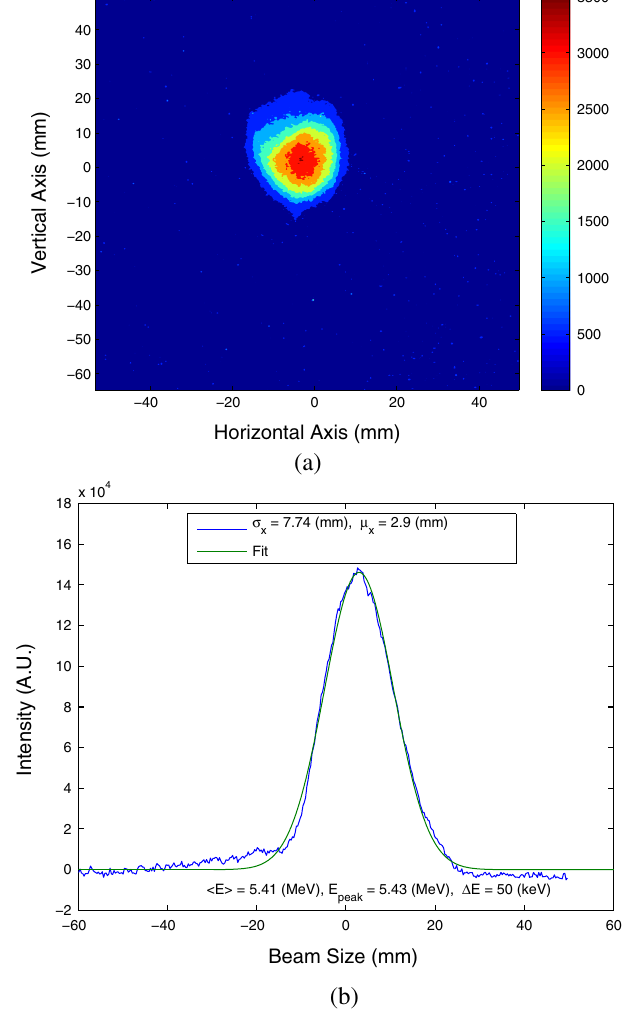
FIG. 14. An example from the energy measurement in the spectrometer by OTR monitoring. (a) The image captured by the CCD camera. (b) The horizontal profile of the image.